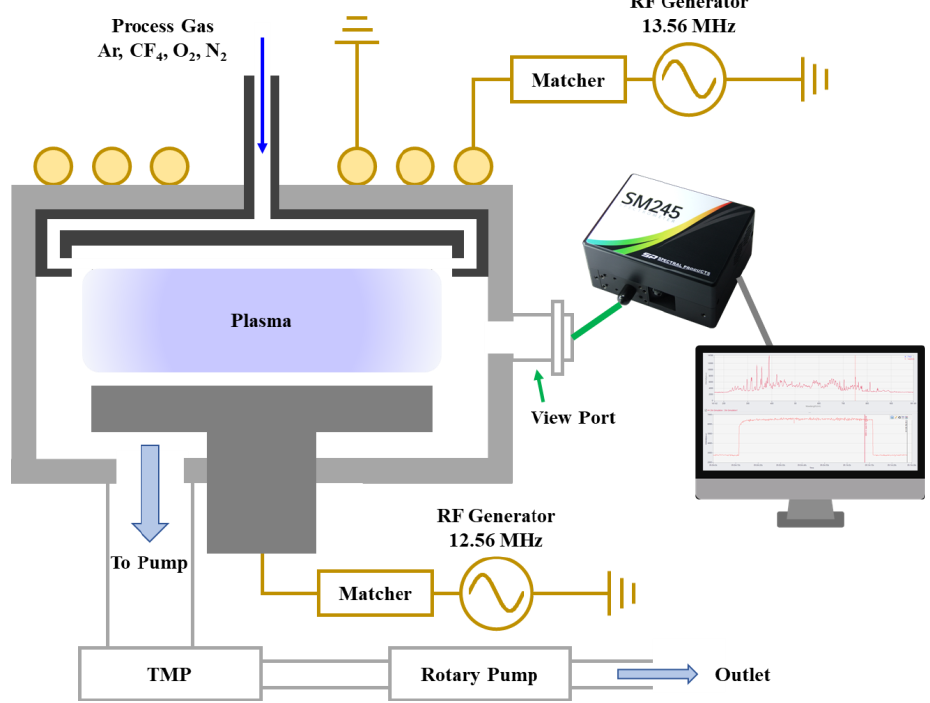
Figure 1. Schematic of the ICP-type chamber with an RF power, vacuum, and sensing units.